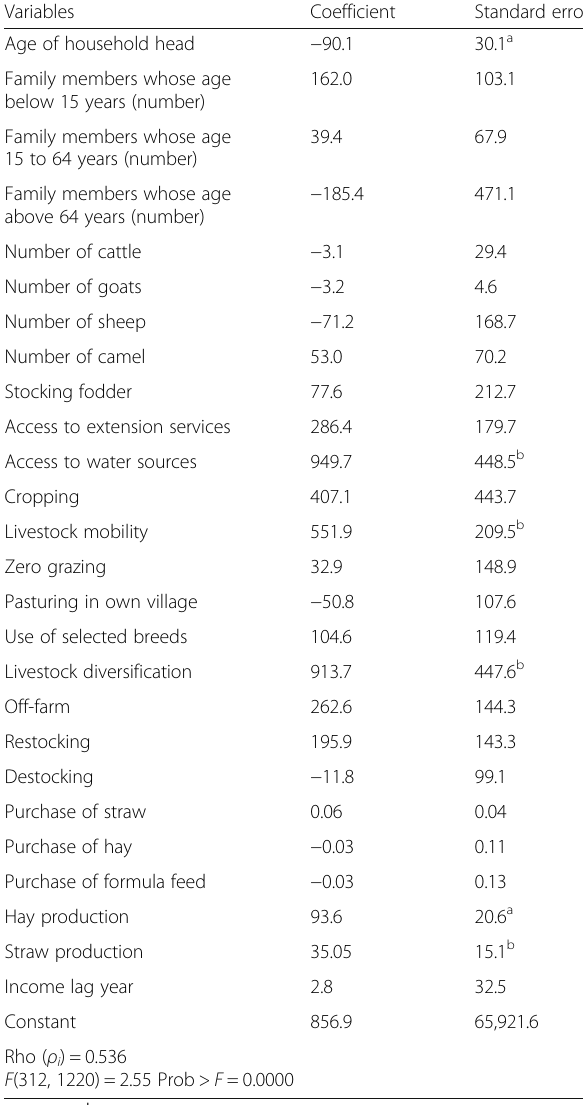
Table 6 Effects of adaptation actions on annual income using fixed effects